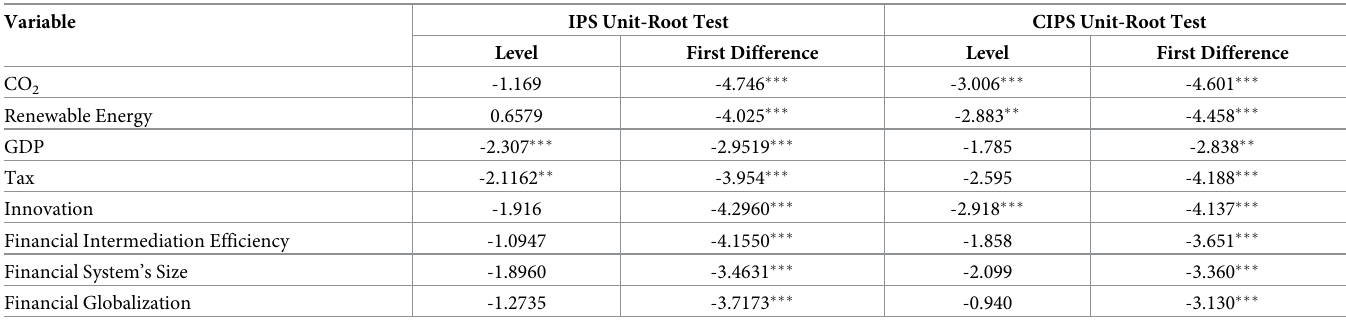
Table 3. IPS and CIPS unit root